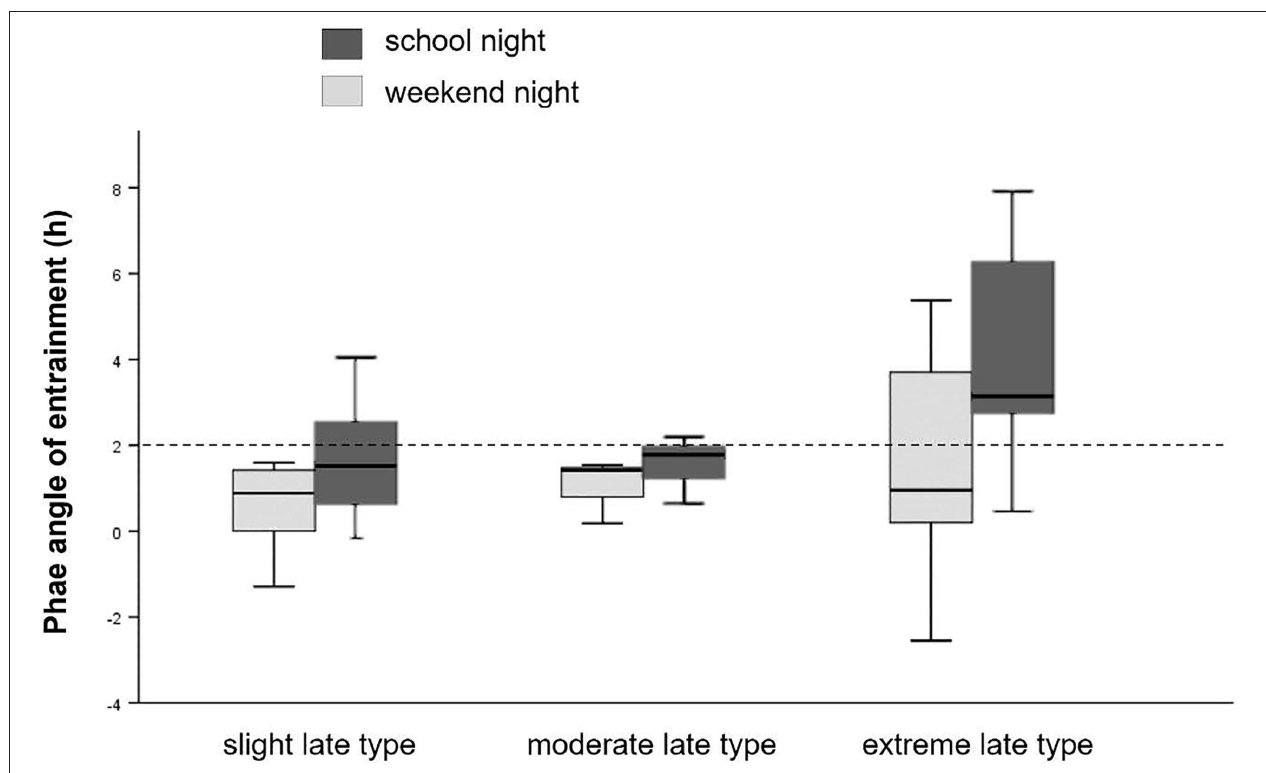
FIGURE 3 | Phase angle of entrainment. Sleep onset timing in relation to DLMO for school- and weekend-nights, separately for chronotype. Dashed line represents the 2h norm difference between DLMO and sleep onset